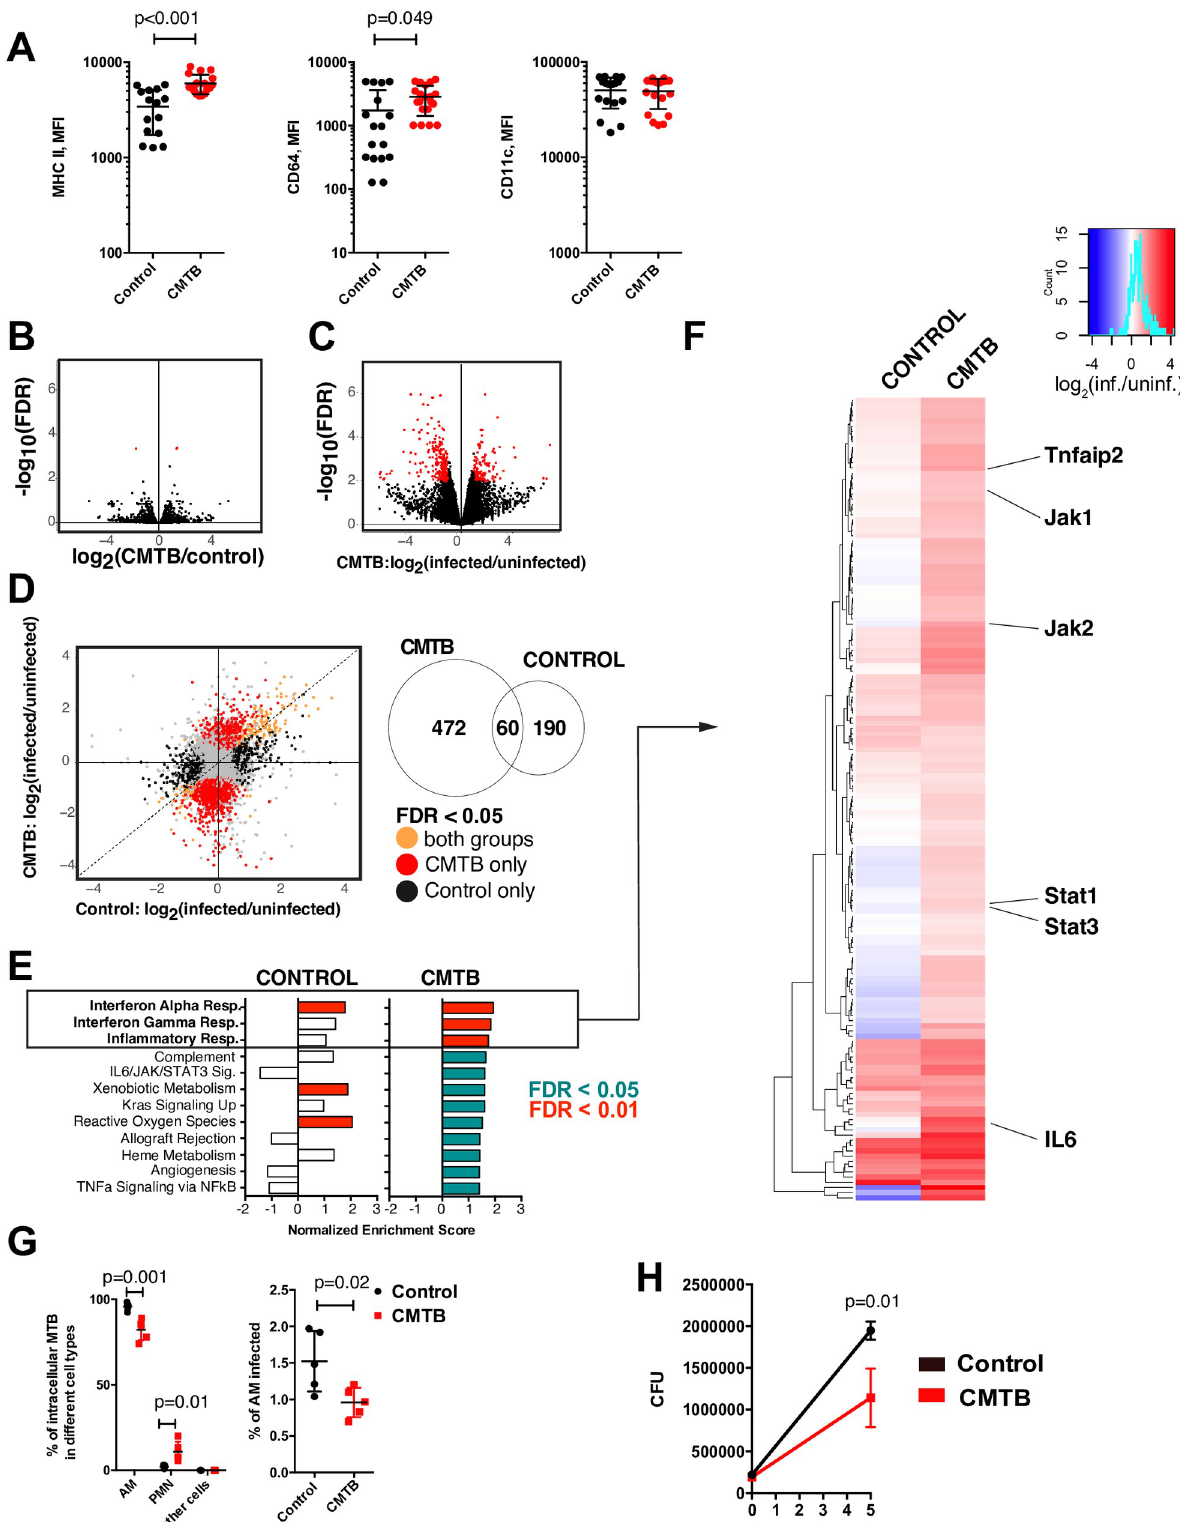
Fig 4. Alveolar macrophages are reprogrammed by CMTB. ( A ) Flow cytometry analysis of AMs from control and CMTB mice (See S19 Fig for gating). Expression of the indicated markers on AMs was quantified by MFI. Significance was determined by Student’s t -Test. Error bars depict